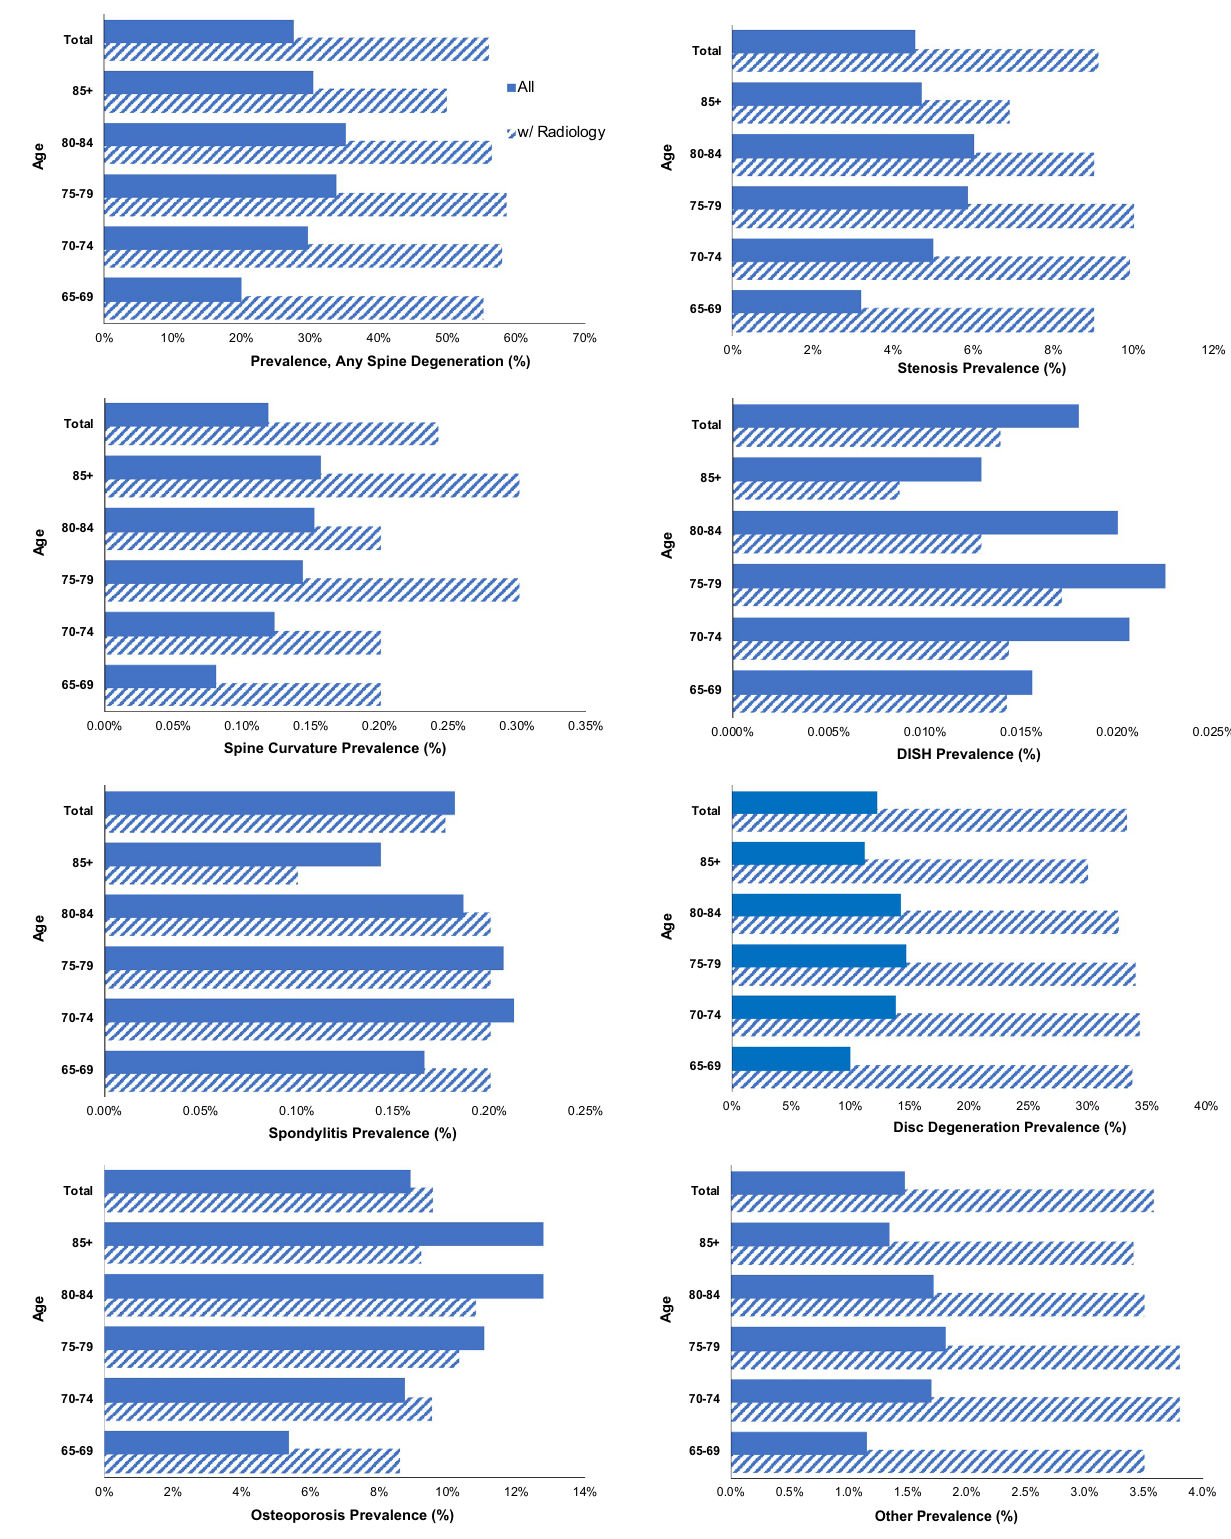
Figure 4. Prevalence of degenerative spine diagnoses by type and age in overall sample and in radiology